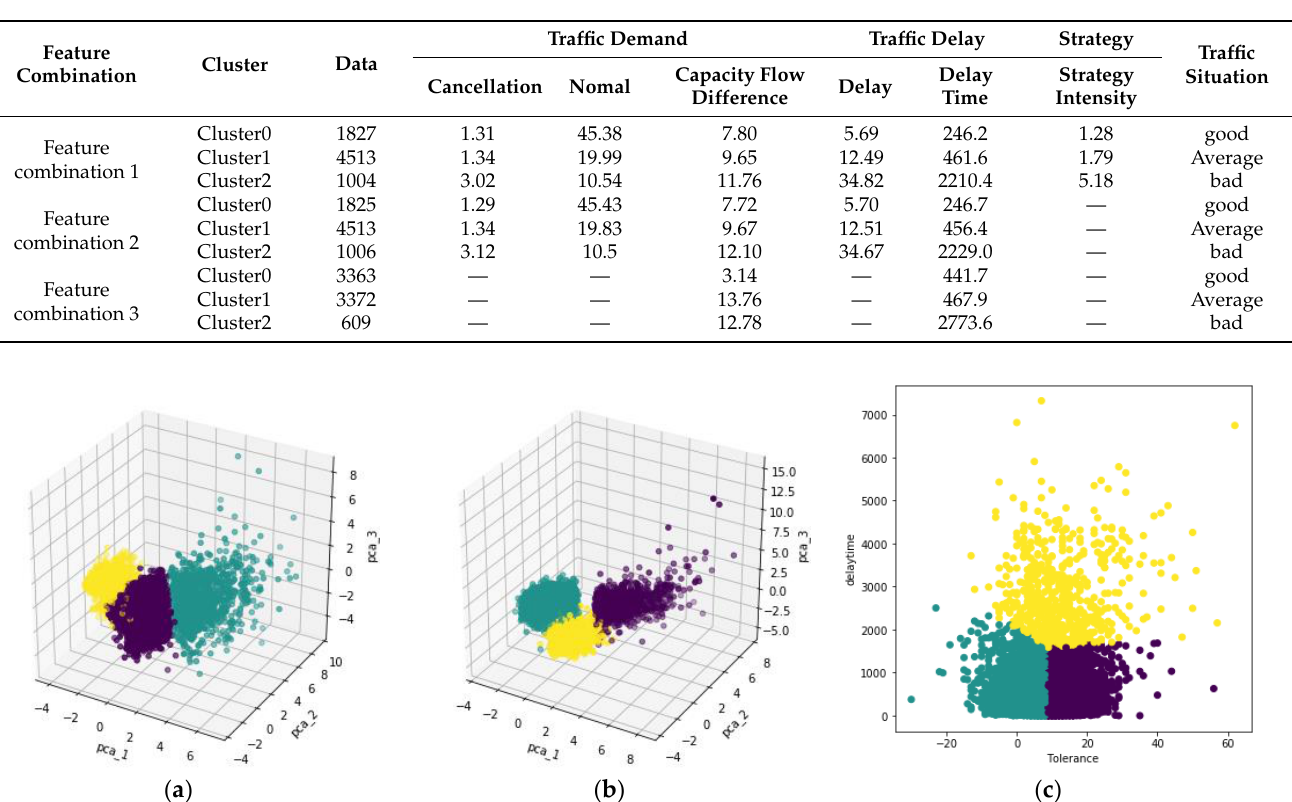
Table 3. Traffic situation based on different feature combination.